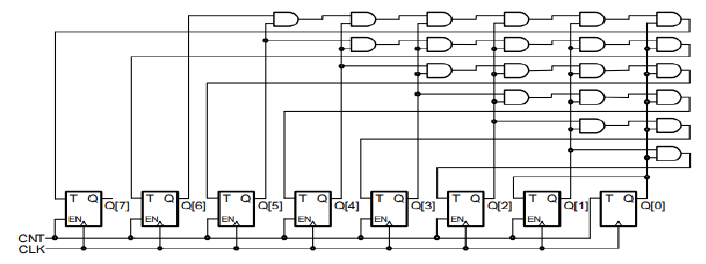
Figure 4 . 8bit synchronous counter made with